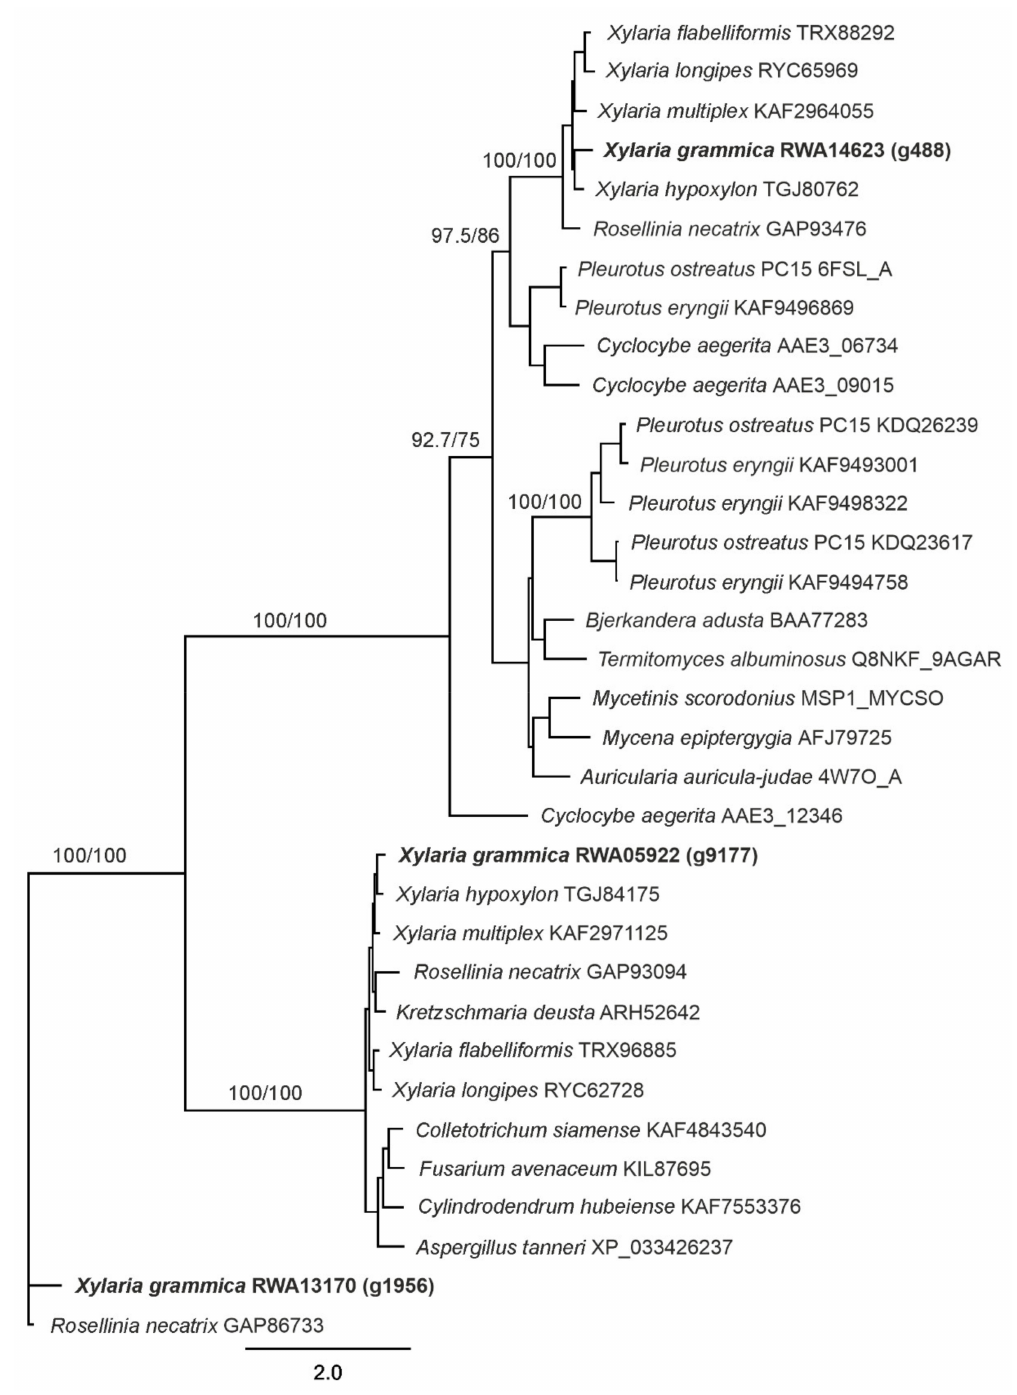
Figure 5. Maximum likelihood phylogenetic tree (log-likelihood: − 18,869.58452) using a DyP protein sequence alignment in PhyML 3.0 [35] with the following model: LG+I+G. Branch support was estimated using a bootstrap approach, first value: 2000 replicates of neighbor-joining trees using Jukes–Cantor distances, second value: 100 replicates of the maximum likelihood approach using LG + I + G